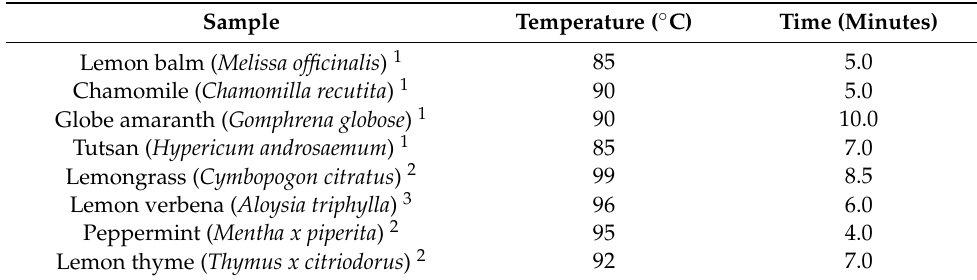
Table 1. Temperature and time of hot water for infusions preparation.